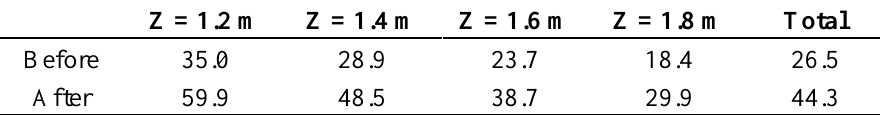
Table 1. Surveillance coverage index before and after adding cameras (unit: %).